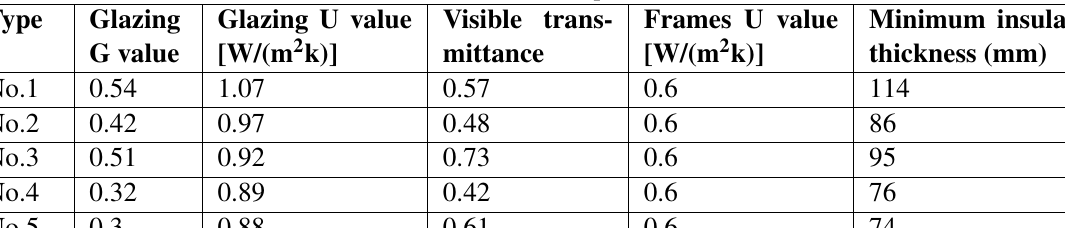
Table 5 Simulation parameters.